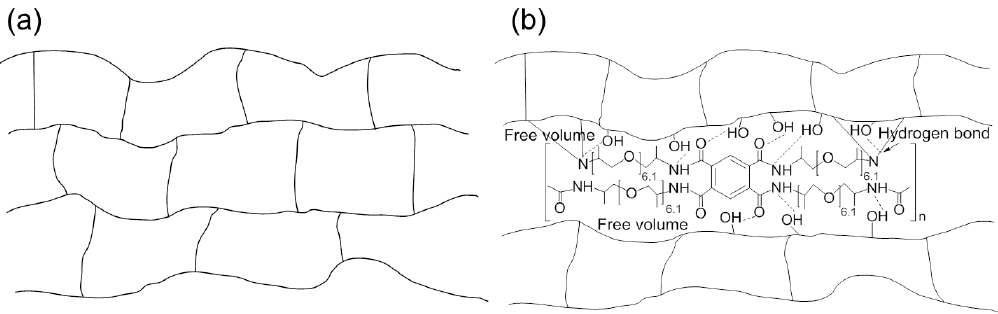
Figure 3. Schematic illustrations of ( a ) neat epoxy networks and ( b ) hydrogen bonds and free volume in BTCP-modified epoxy networks. Table 1. Formulations of epoxy compositions.